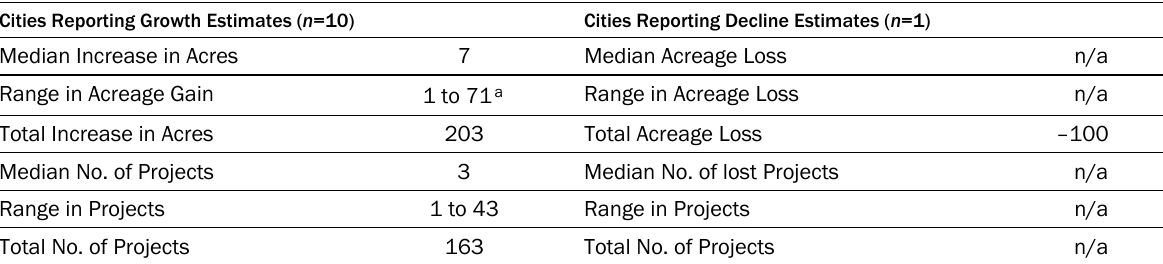
Table 1. Median Change in Southern Urban Agriculture over 10 Years: Acreage and Projects Cities Reporting Growth Estimates ( n